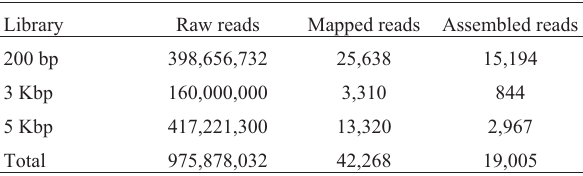
Table1 -Numberofreadsper A.aestiva sequencinglibrary.Totalnumber of raw reads per library, reads that were mapped to the Amazona barbadensis mitogenome, and total number of reads used in the assembly of the mitogenome A. aestiva .